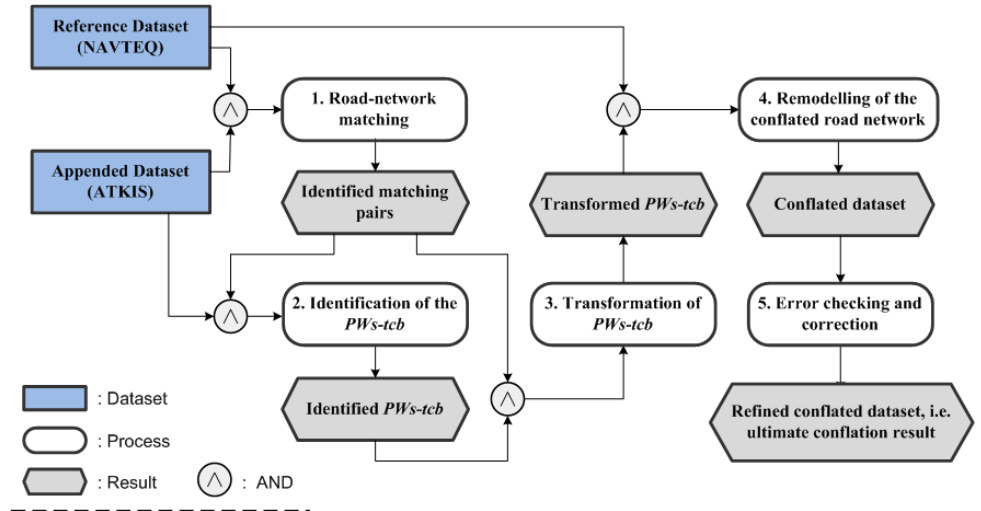
Figure 1. Strategy to achieve the conflation of different road networks.